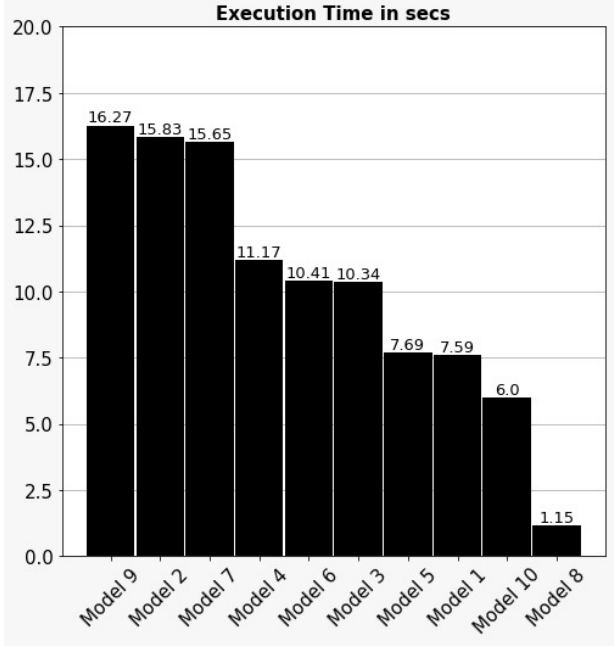
Figure 11. Execution time of all the models on the fog